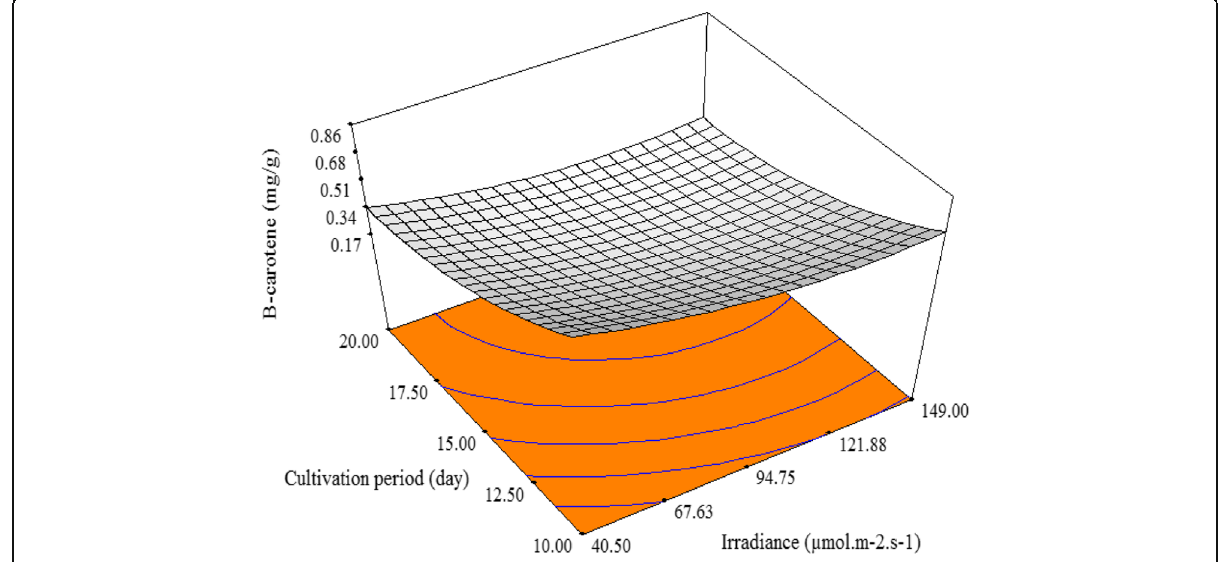
Fig. 6 The RSM model graph of β -carotene